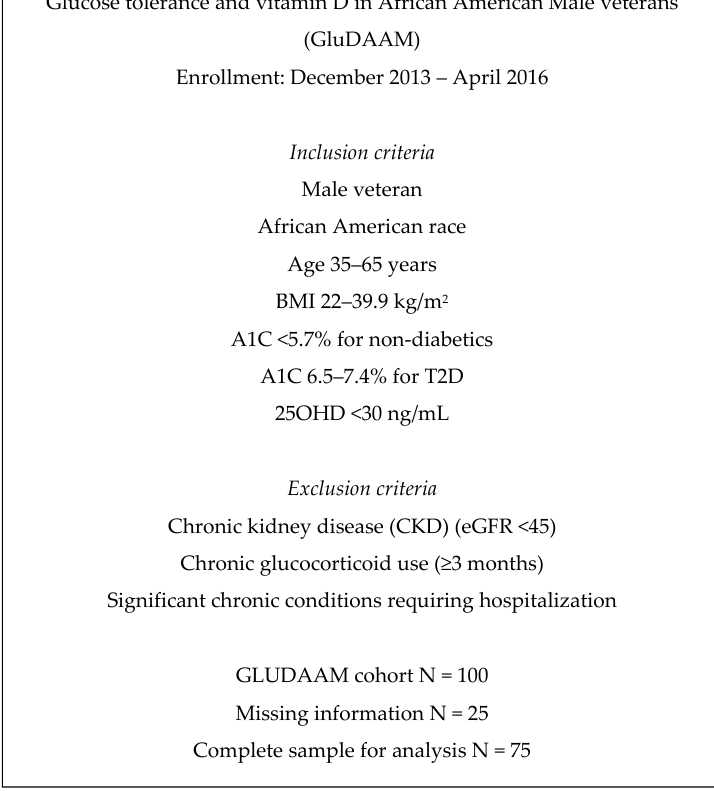
Figure 1. Overall Design of Study.